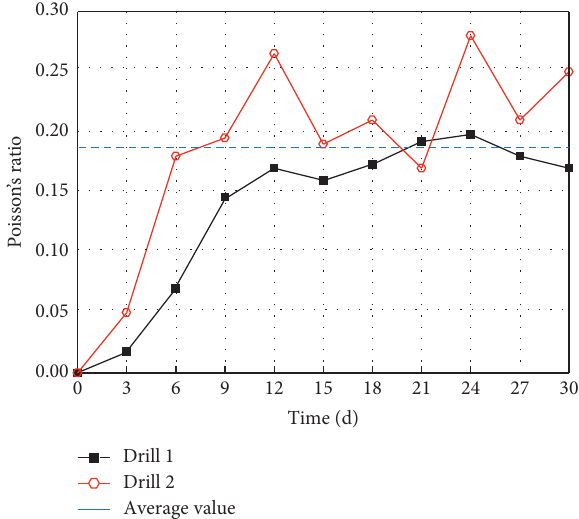
Figure 9: Trend of Poisson’s ratio with the underground curing